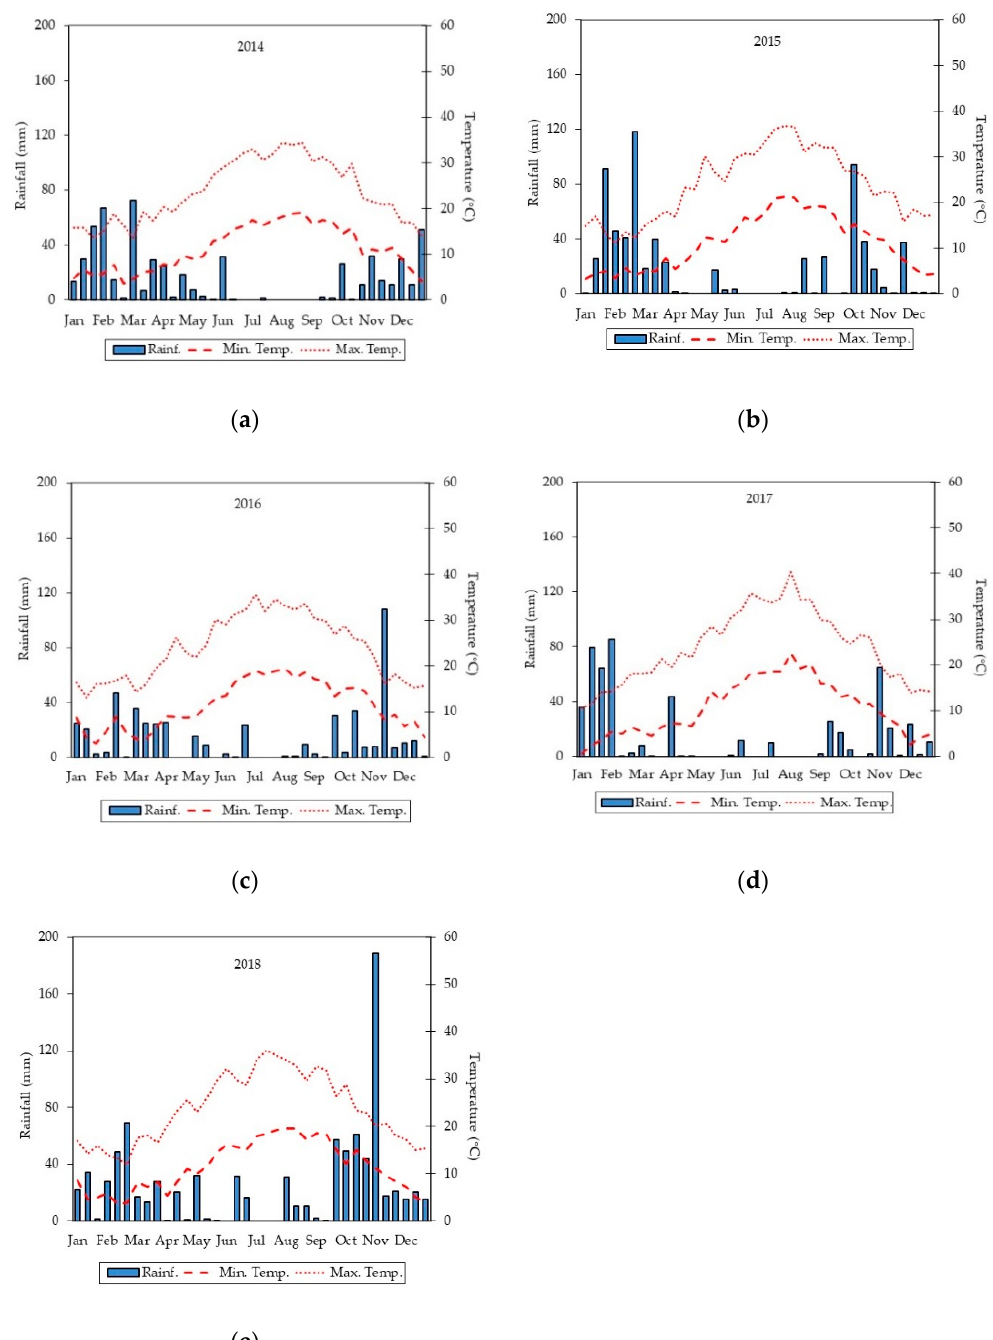
Figure 3. Rainfall and air temperature trends during the study period in the experimental area. Graph ( a ) refers to 2014, graph ( b ) refers to 2015, graph ( c ) refers to 2016, graph ( d ) refers to 2017, and graph ( e ) refers to 2018.